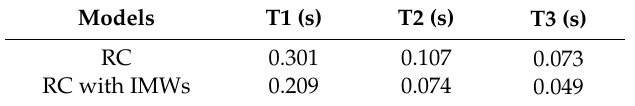
Figure 7. Shear stress vs. shear strain relationship for Concrete02: core ( a ) and cover ( b ) and Steel02 ( c ) [27]. Table 2. Structural periods; reinforced concrete (RC), infill masonry walls (IMWs).